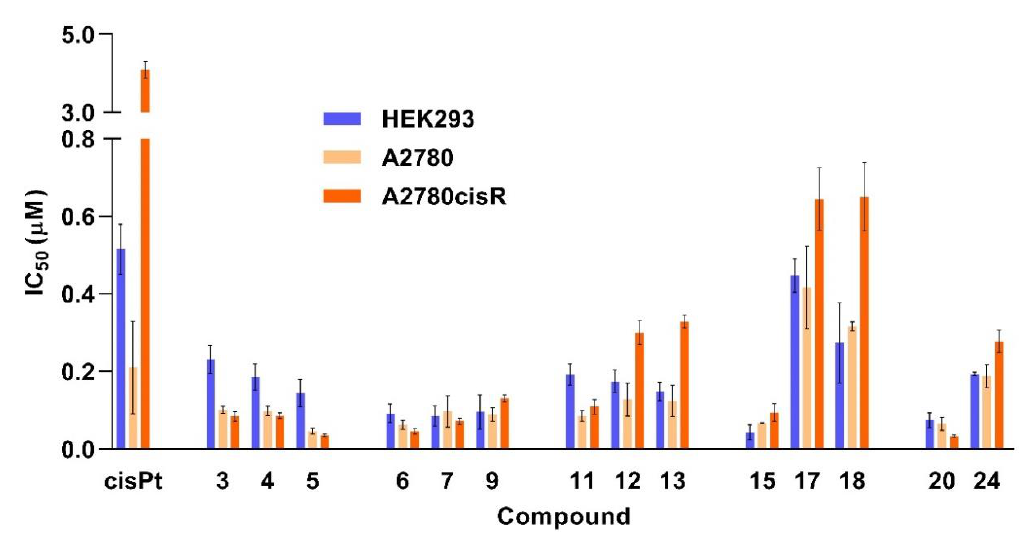
Figure 5. Comparison of the IC 50 values (μM, 72 h) determined for cisplatin (cisPt) and selected trithiolato-bridged dinuclear ruthenium(II)- p -cymene compounds toward human ovarian A2780 and A2780cisR (cisplatin sensitive and resistant) cancer cells and human embryonic kidney HEK293 cells.